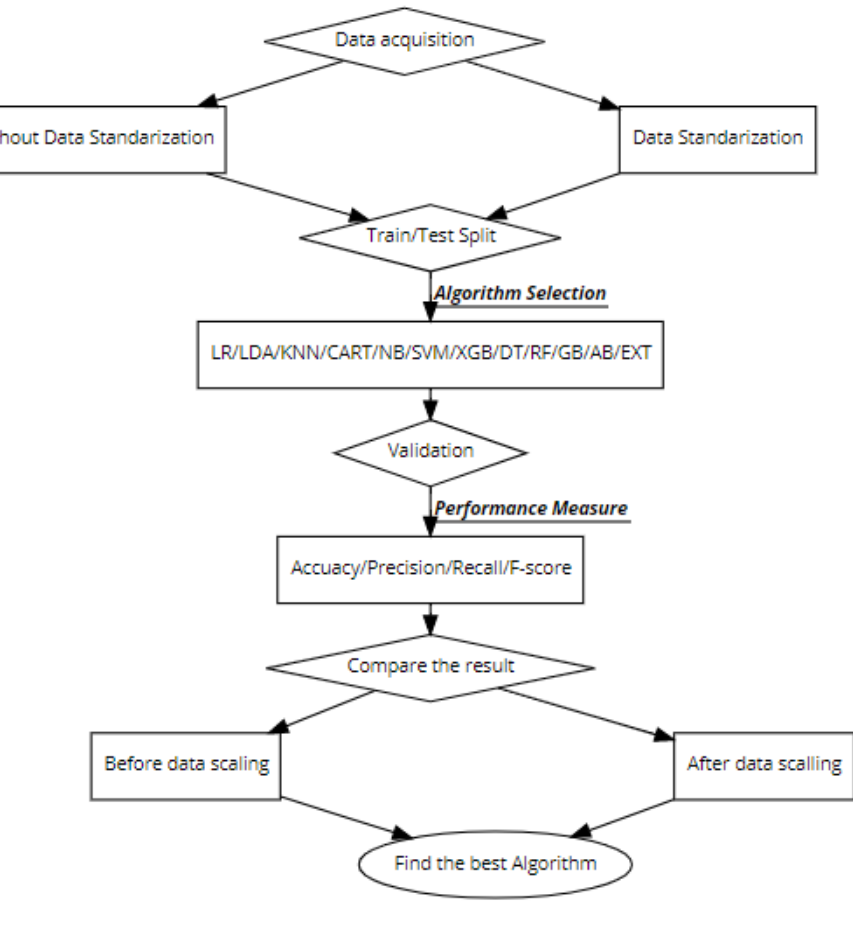
Figure 4. Flow chart of overall experiment.